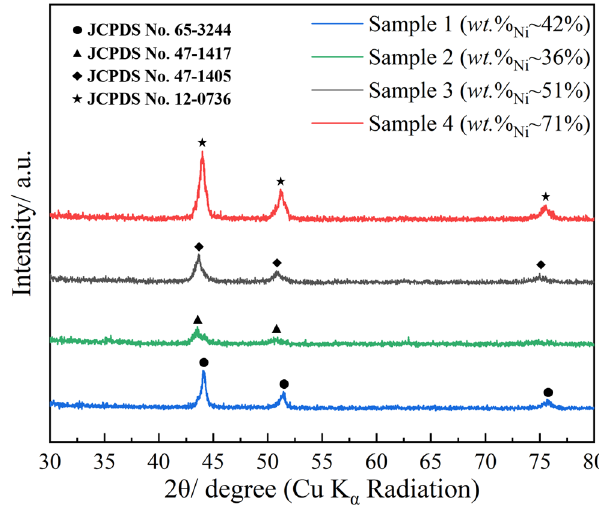
Figure 4. XRD pa tt erns of samples 1 to 4. Table 2. Detailed value of the di ff raction peaks and the calculated parameters. Sample No.